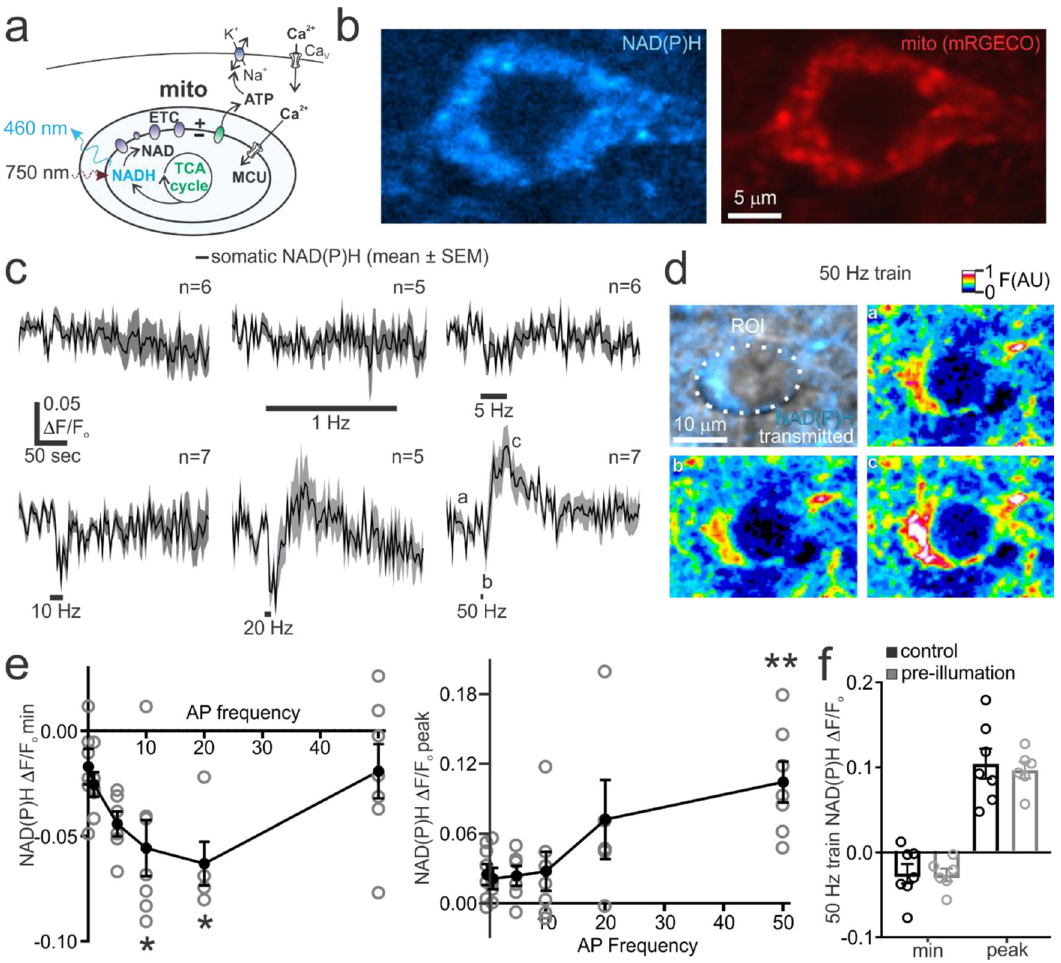
Fig. 4 Measurement of action potential evoked NAD(P)H dynamics in single pyramidal neurons in situ. a Left , Illustration depicts the generation of fl uorescent NADH by the TCA cycle and its oxidation to non- fl uorescent NAD + by the electron transport chain (ETC). NADH auto fl uorescence can be measured using two-photon excitation at 750nm. b Images of a cortical pyramidal neuron showing the punctate pattern of intracellular NAD(P)H auto fl uorescence and mitochondria labelled with mRGECO. c Group time series data showing the enlargement of somatic NAD(P)H transients with progressively higher action potential fi ring frequencies in a cortical pyramidal neuron. Labels during the 50Hz train highlight the pre-stimulus phase ( a ), the stimulus-evoked transient decrease ( b ), and the long-lasting elevation of NAD(P)H auto fl uorescence ( c ). Images from these time points are depicted in panel D. d NAD(P)H auto fl uorescence in a pyramidal neuron soma during the baseline ( a ), immediately following a 50Hz, 4-sec action potential train ( b ), and tens of seconds post-stimulus ( c ). The region of interest (ROI) used for analysis is depicted. e Relative to unstimulated neurons ( n = 6, N = 4) train-evoked evoked NAD(P)H dips (min) ( Left ) and transient peaks ( Right ) signi fi cantly increase in magnitude with higher action potential fi ring frequency (NAD(P)H min data, One-way ANOVA and Dunnett ’ s multiple comparisons test: 1Hz train, n = 5, N = 2, p = 0.976; 5Hz train, n = 6, N = 4, p = 0.274; 10Hz, n = 7, N = 3, p = 0.05; 20Hz train, n = 5, N = 2, p = 0.028; 50Hz train, n = 7, N = 4, p = 0.99; NAD(P)H peak stats, One-way ANOVA and Dunnett ’ s multiple comparisons test: 1Hz train, n = 5, N = 2, p = 0.99; 5Hz train, n = 6, N = 4, p >0.999; 10Hz, n = 7, N = 3 , p = 0.99; 20Hz train, n = 5, N = 2, p = 0.263; 50Hz train, n = 7, N = 4, p = 0.0097. f Prior exposure of neurons to 5min of 750nm excitation light had no signi fi cant effect on NAD(P)H dips or latent peaks triggered by a 50Hz train of action potentials (NAD(P)H min data, control: n = 7, N = 4; pre- illumination: n = 6, N = 4; unpaired t test, p = 0.92; NAD(P)H peak data, control: n = 7, N = 4; preillumination: n = 6, N = 4; unpaired t test, p = 0.72). Summary data presented as the mean±SEM. * P <0.05, ** P <0.01. The number of cell replicates is shown in the graphs as well as the ‘ n ’ value in the text. The number of animal replicates is represented by the ‘ N ’ auto fl uorescence relative to controls (Fig. 5a, b). Moreover, the latent NAD(P)H overshoot phase was substantially depressed in the presence of Ru360. These data indicate that the MCU has a